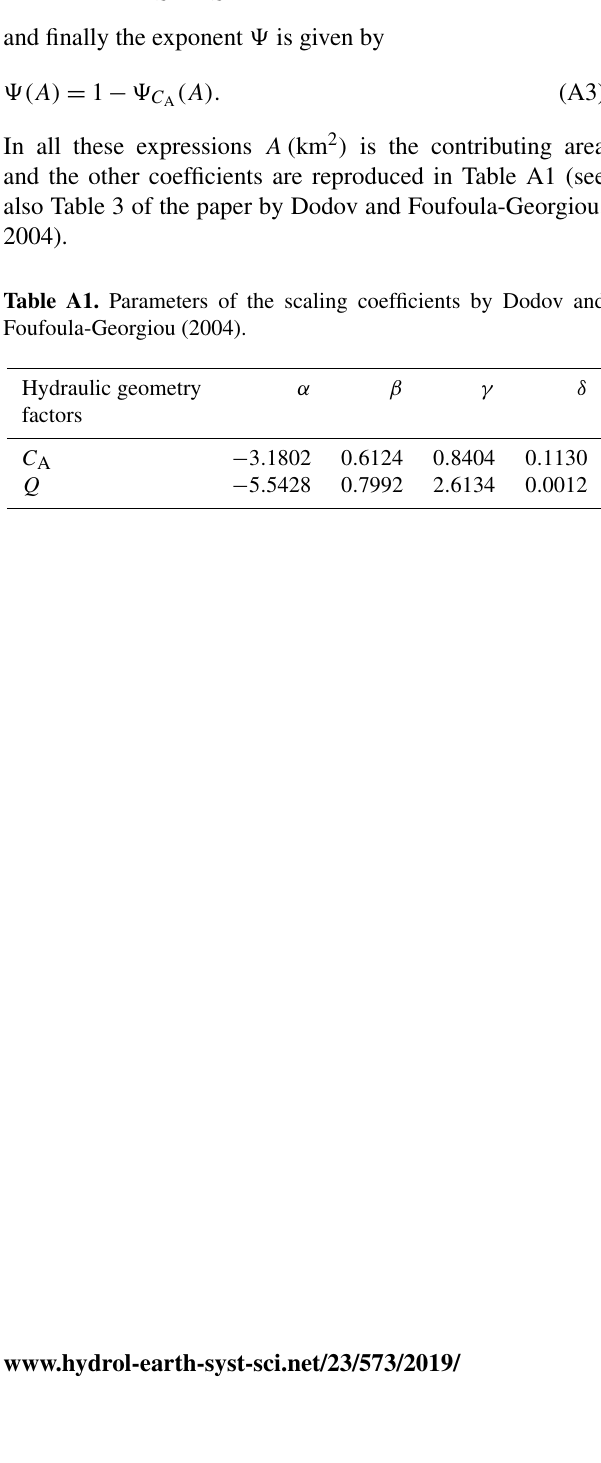
Table B1. List of the WWTPs with a maximum capacity of more than 10000 persons equivalent considered in the application at the catchment scale. The assigned identification numbers (ID) are sorted by latitude (from the southernmost to northernmost plants) and the coordinates are expressed in meters (UTM WGS